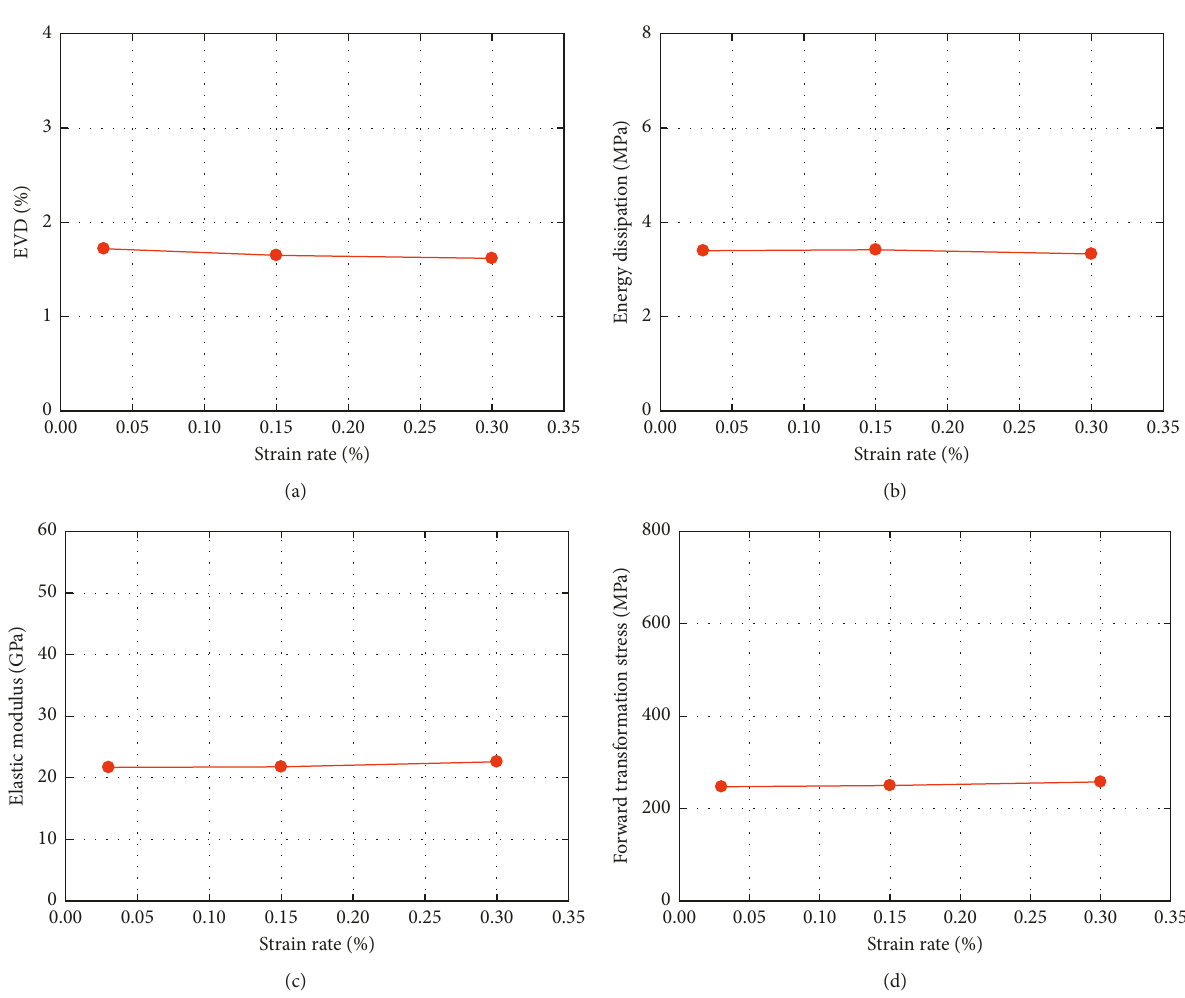
Figure 11: Effect of loading rate on mechanical properties. Effect on (a) EVD, (b) energy dissipation, (c) elastic modulus, and (d) forward transformation